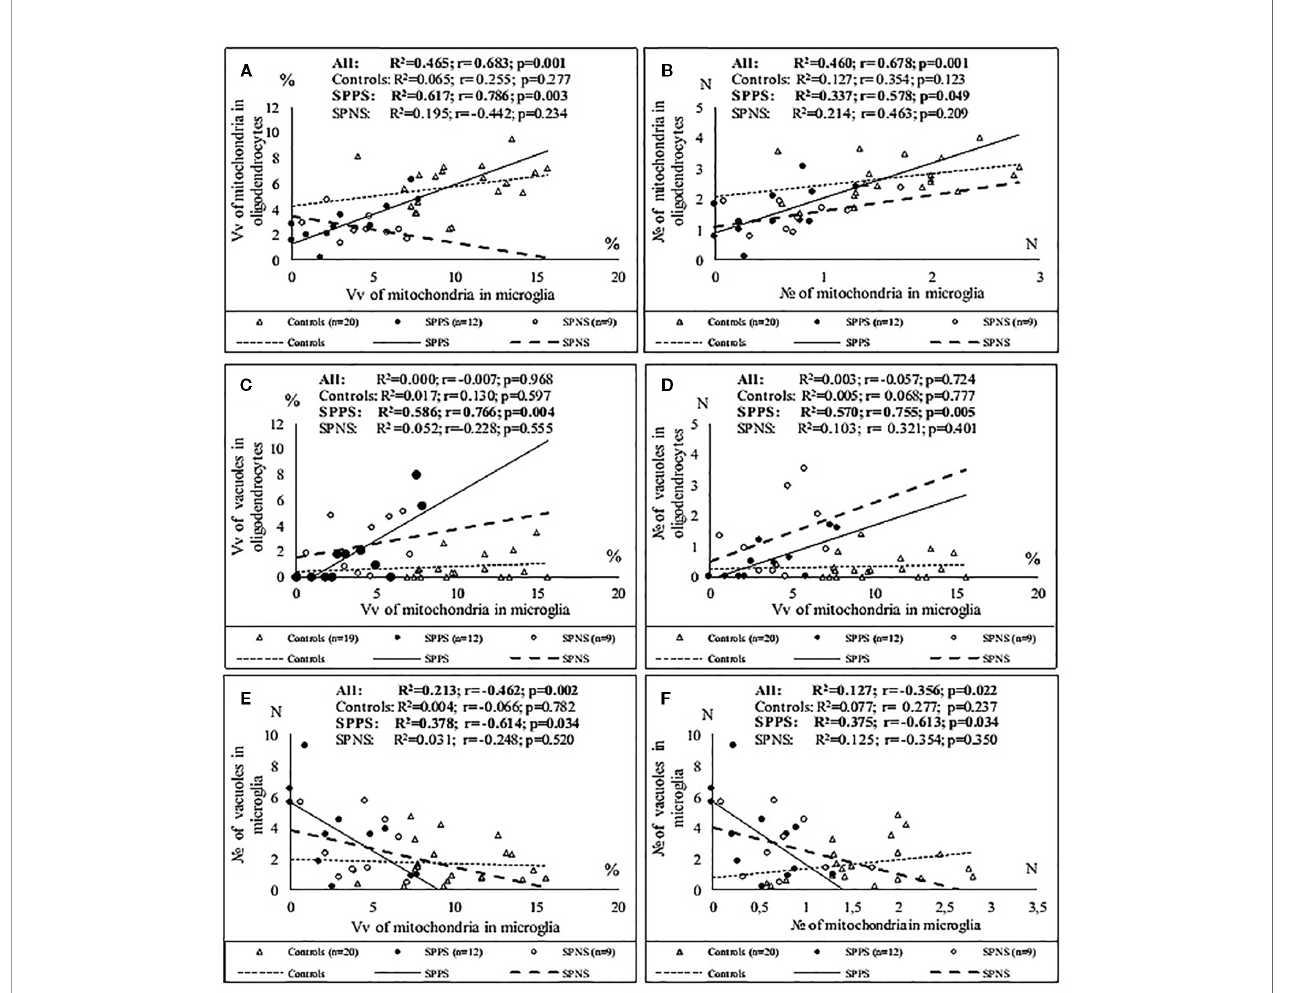
FIGURE 4 | Positive signi fi cant correlations between Vv and N of mitochondria in microglia and Vv and N of mitochondria in oligodendrocytes (A, B) ; positive signi fi cant correlations between Vv of mitochondria in microglia and Vv and N of vacuoles in oligodendrocytes (C, D) and negative signi fi cant correlations between Vv and N of mitochondria and N of vacuoles in microglia (E, F) in the SPPS